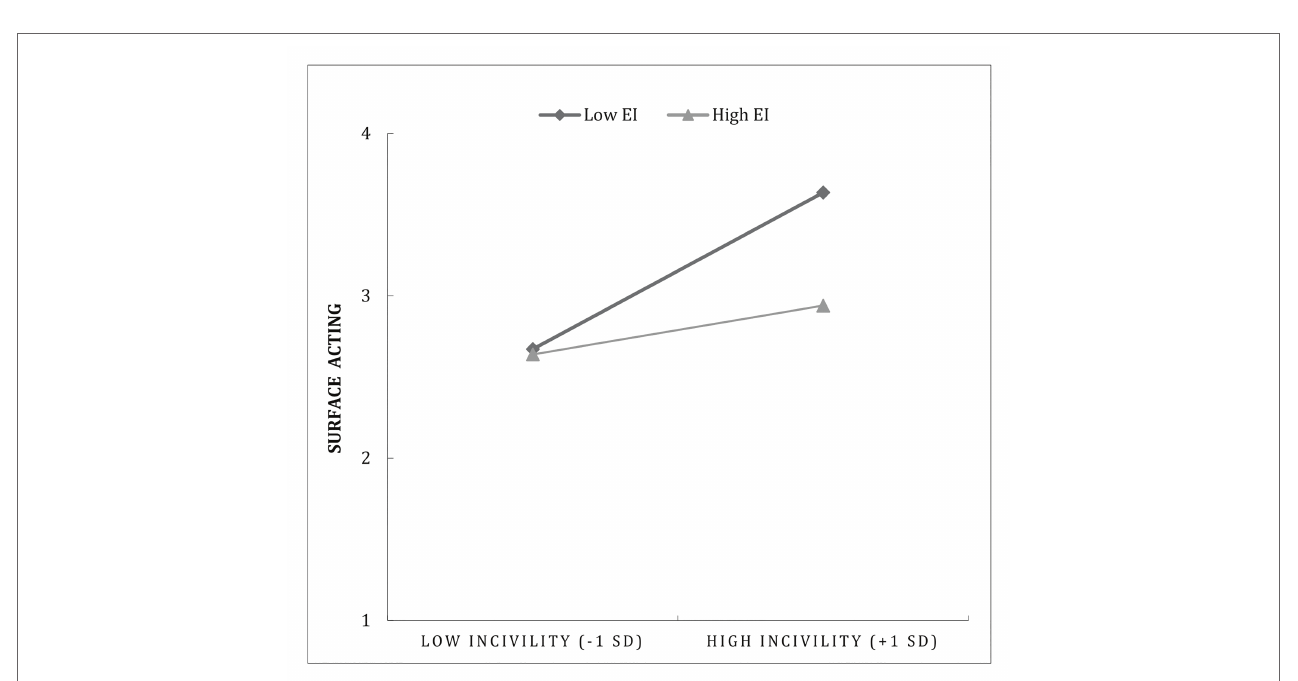
FIGURE 3 | Surface acting as a function of the interaction between customer incivility and emotional